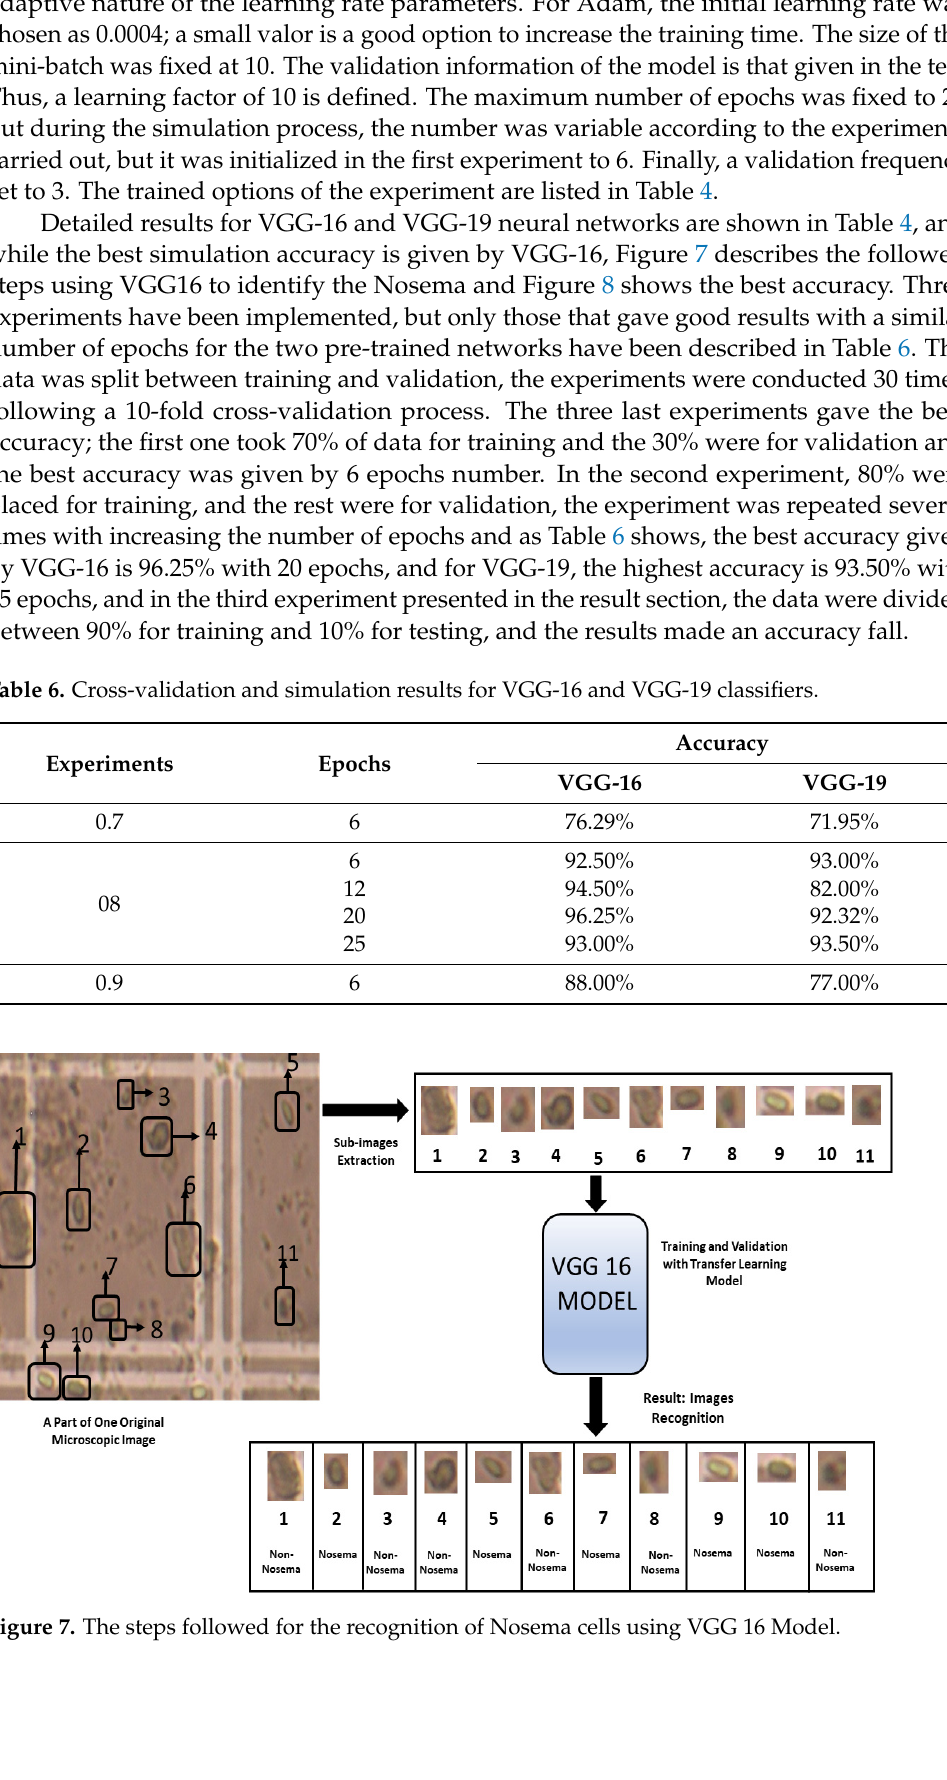
Figure 8. The Accuracy (blue curve) and loss (orange curve) results given by VGG-16 simulation: 96.25% of success accu- racy with 20 epochs.